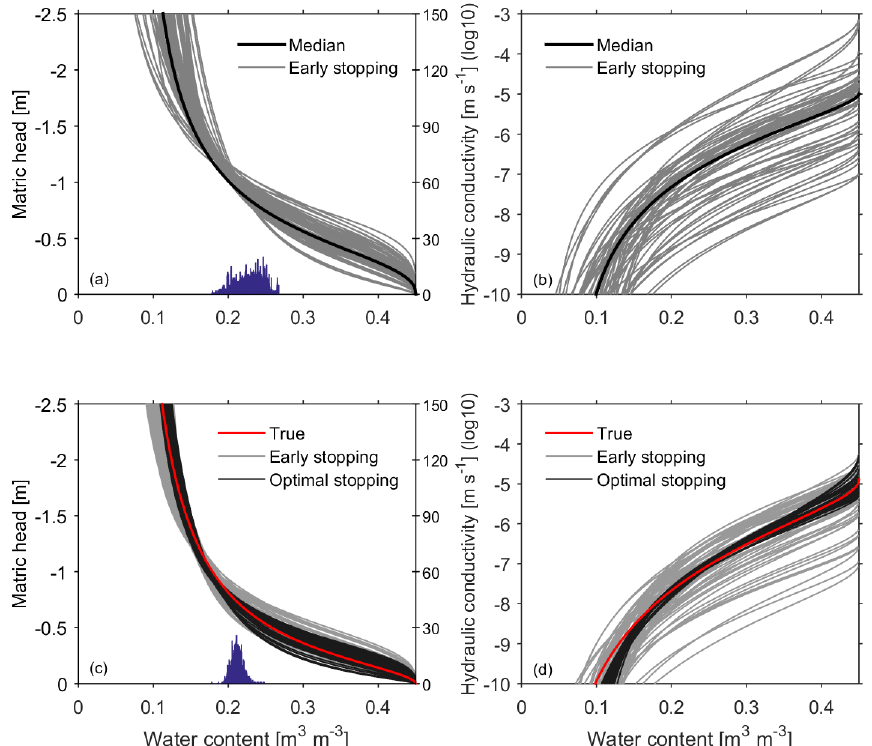
Figure 4. Effective hydraulic properties estimated with the proposed approach for the field study (a, b) and the synthetic study (c, d) . The grey curves in all subplots represent estimated hydraulic functions from ensemble members using the early stopping criterion. The black curves in (a) and (b) are derived from the median parameters of the best 68 members, while the black curves in (c) and (d) are the same members but using the optimal stopping criterion. The red curves in (c) and (d) are derived from the true parameter given in Table 2. The histograms in (a) and (c) (blue histogram; the same in Figs. 6 and 7) mark the covered range of the mean water content evaluated from the GPR